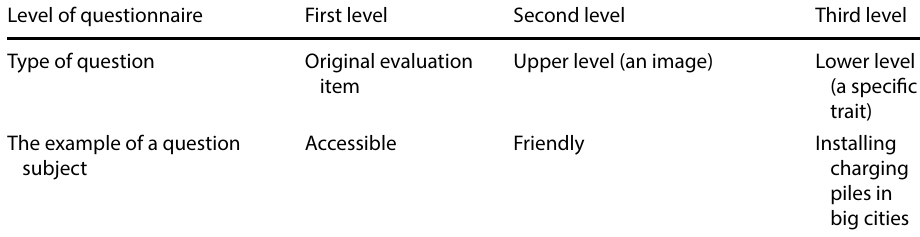
Table 2 The setting of the level-based construction of